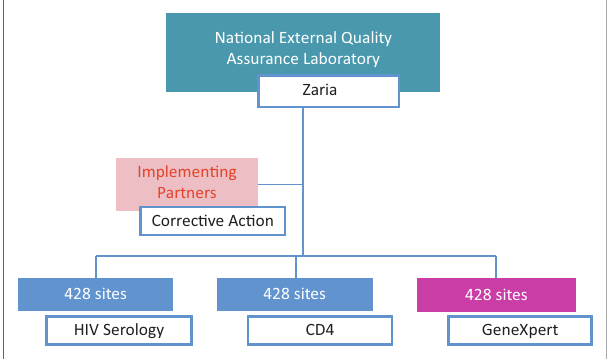
FIGURE 3: Nigeria centralised national external quality assessment model.